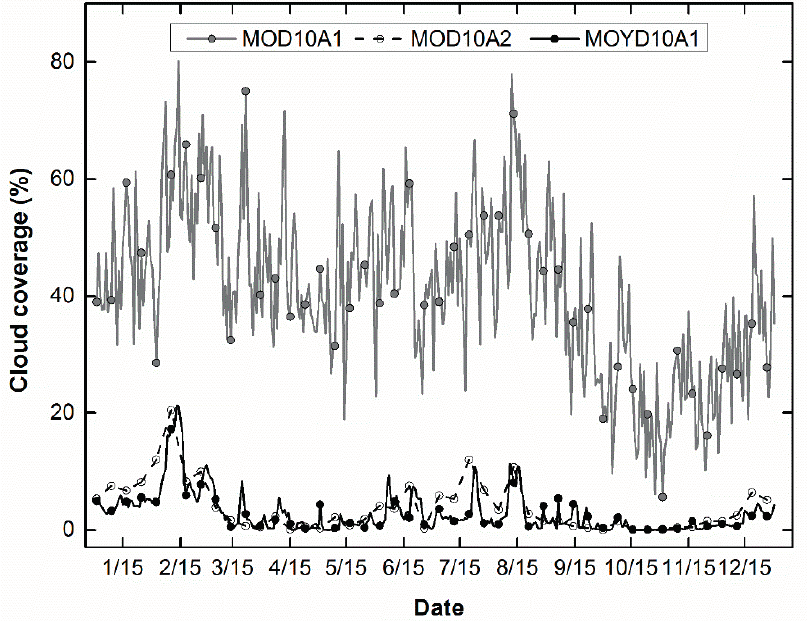
Figure 10. Average daily cloud cover percentages of three snow cover data: MODIS Terra daily snow cover (MOD10A1), MODIS Terra eight-day maximum snow cover (MOD10A2), and our cloud-gap-filled daily snow cover (MODMYD10A1) from October 2002 to September